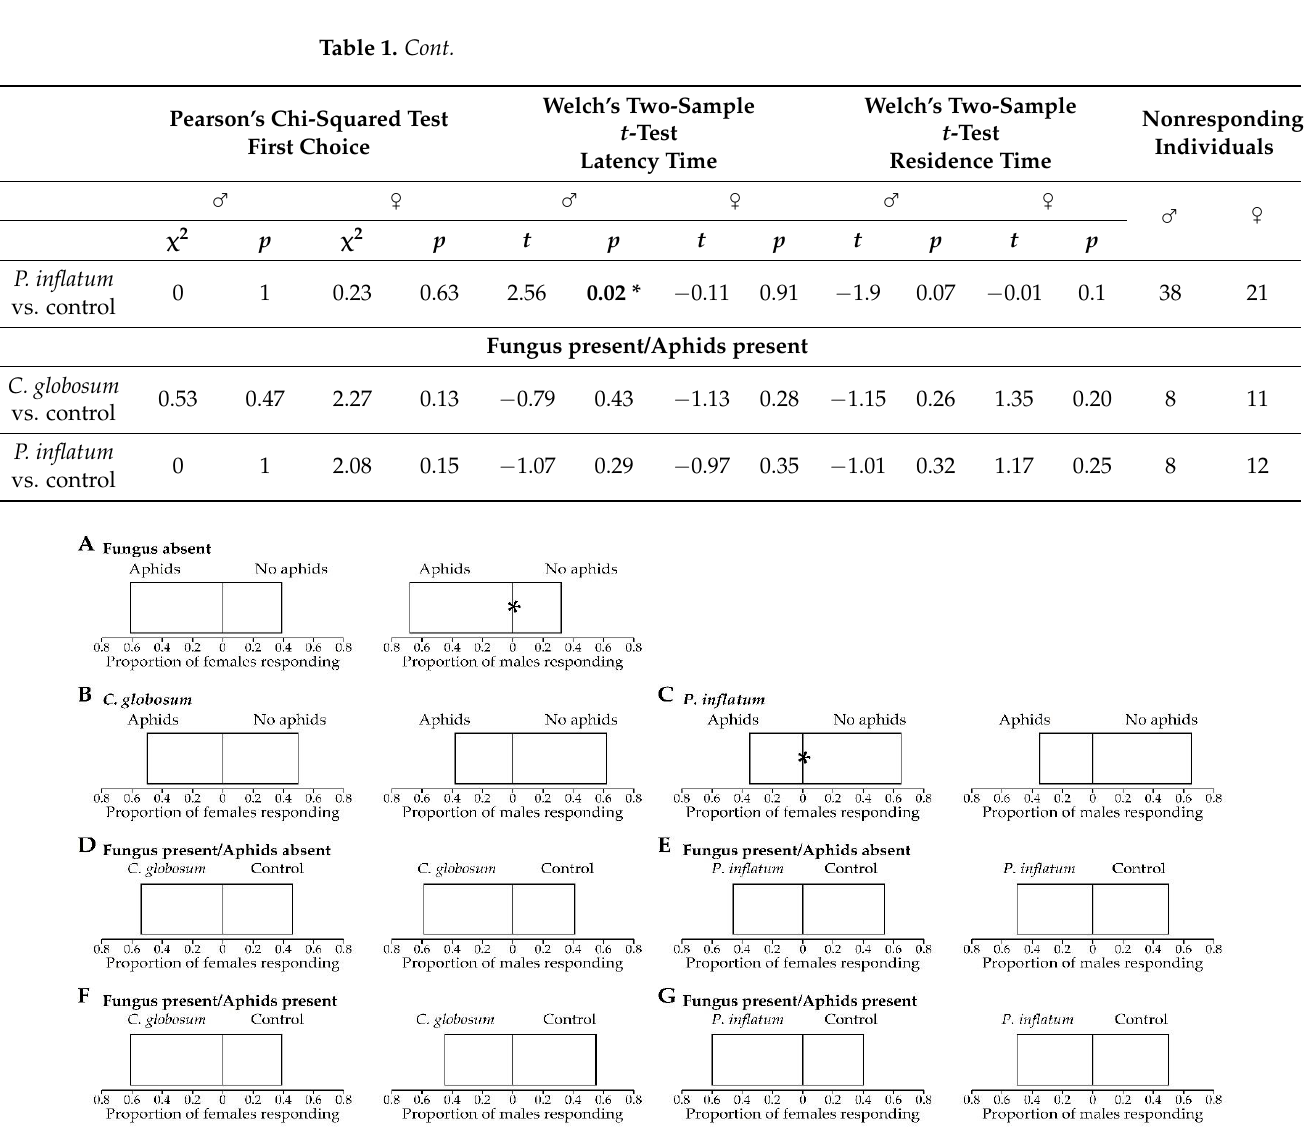
Figure 2. Proportion of Hippodamia convergens females and males responding to untreated control and fungal-treated ( Chaetomium globosum and Phialemonium inflatum ) cotton plants in a dual-choice Y-tube olfactometer. ( A – C ) Untreated plants, C. globosum, and P. inflatum treated plants with aphids vs. no aphids, respectively. ( D , E ) Fungal-treated plants vs. untreated plants, both without aphids. ( F , G ) Fungal-treated plants vs. untreated plants, both with aphids. Each individual had 300 s (five minutes) to make a choice from a total of 600 s, and the beetles that did not respond were not included in the analysis. * p < 0.05 (Pearson’s chi-squared test).